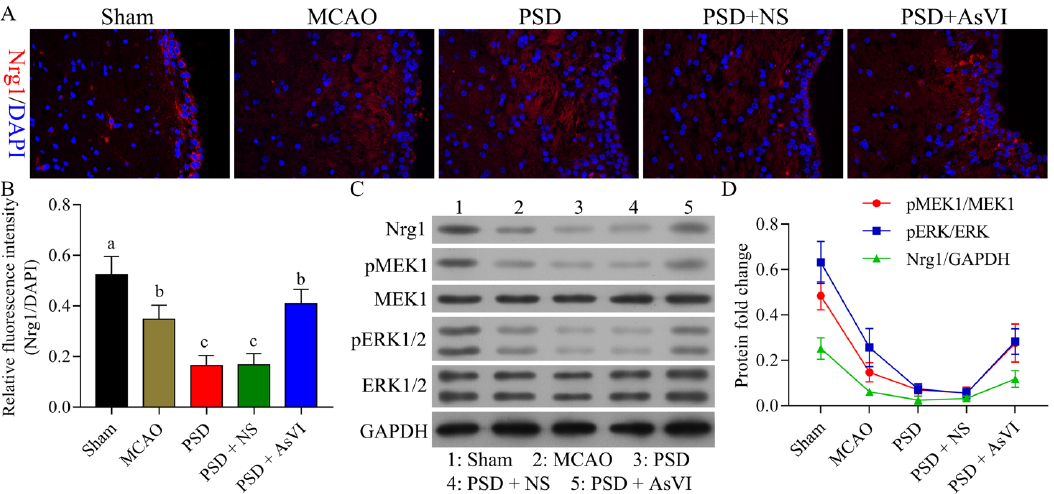
Figure 5. Impacts of AsVI on NRG-1, MEK1, and ERK1/2 expression in the PSD rats’ brain tissues. ( A ) Immunofluorescence was utilized to analyze the expression of neuregulin-1 (NRG-1) in brain tissues from rats in different cohorts. 400× magnification. ( B ) Statistical analysis of the fluorescence intensity of NRG-1 in respective cohorts. ( C , D ) The NRG-1, MEK1, p-MEK1, ERK1/2, and p-ERK1/2 expression in the brain tissue of PSD rats was measured utilizing western blotting. GAPDH was employed as an internal control. Data are articulated as means ± SDs. n = 3–5 rats in the cohorts. Distinct letters (a, b, c, d) denote significant differences in various cohorts p <